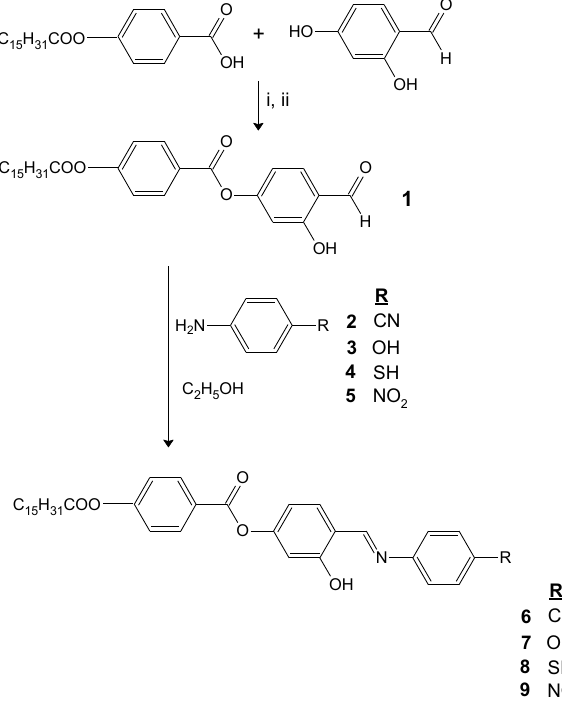
Figure 1. Synthetic routes towards the formation of intermediates and target compounds 6 - 9 . Reagent and conditions: (i) SOCl (C H ) N, N atmosphere, reflux for 5 2 5 3 2